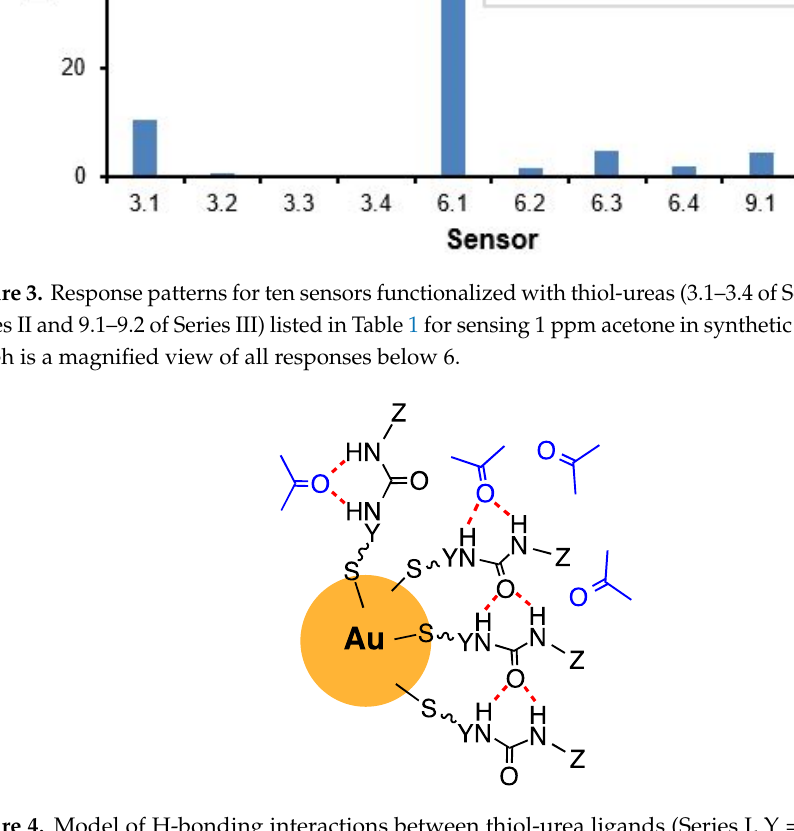
Figure 4. Model of H-bonding interactions between thiol-urea ligands (Series I, Y = O; II, Y = CH 2 ; III, Y = O) and acetone at the surface of AuNPs where Z = peripheral alkyl, aryl, or alkoxy group.